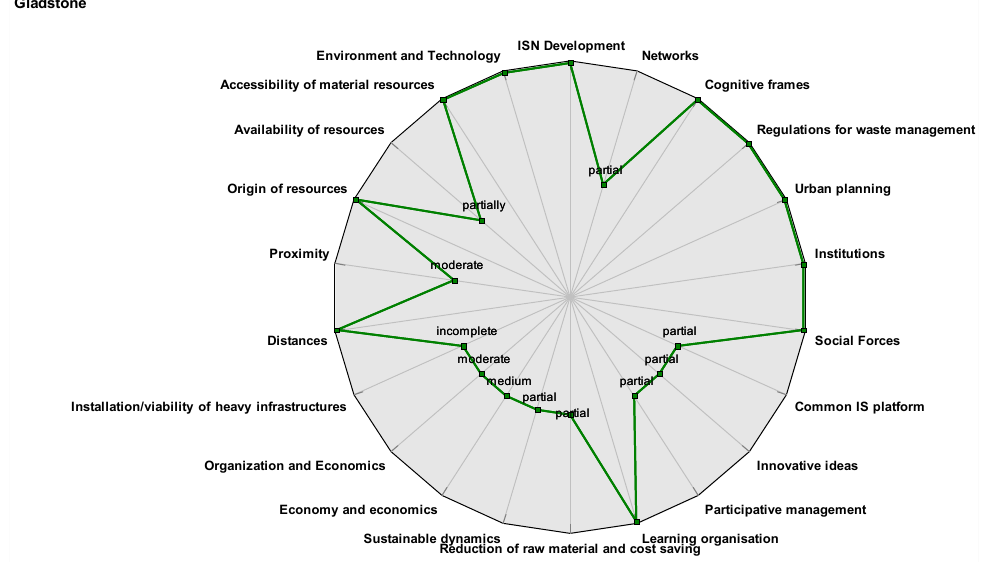
Figure 7. Polar chart of the selected attributes for ISN in Gladstone.